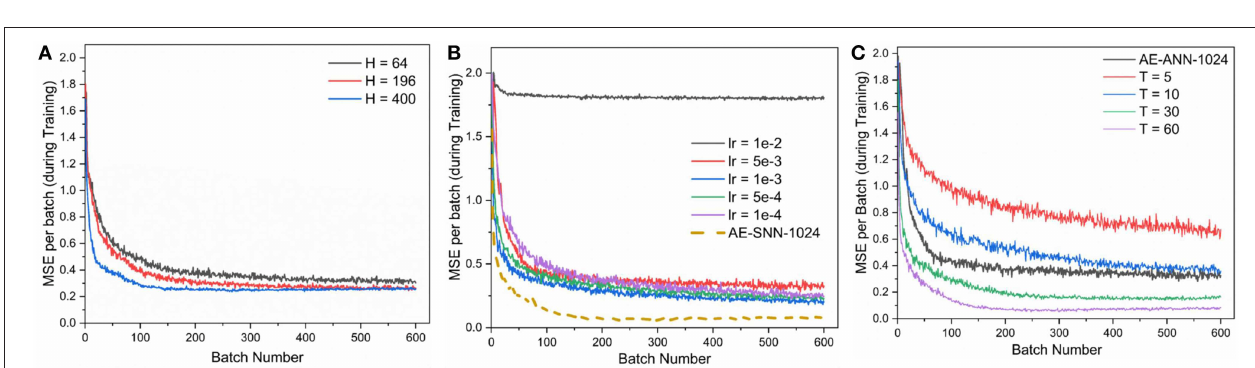
FIGURE 6 | AE-SNN trained on Fashion-MNIST (training examples = 60,000, batch size = 100) (A) AE-SNN [784 × (512/1,024) × 784] vs. AE-ANNs (trained with/without Adam, lr = 5e-3). (B) Regenerated images from test set for AE-SNN-1024.